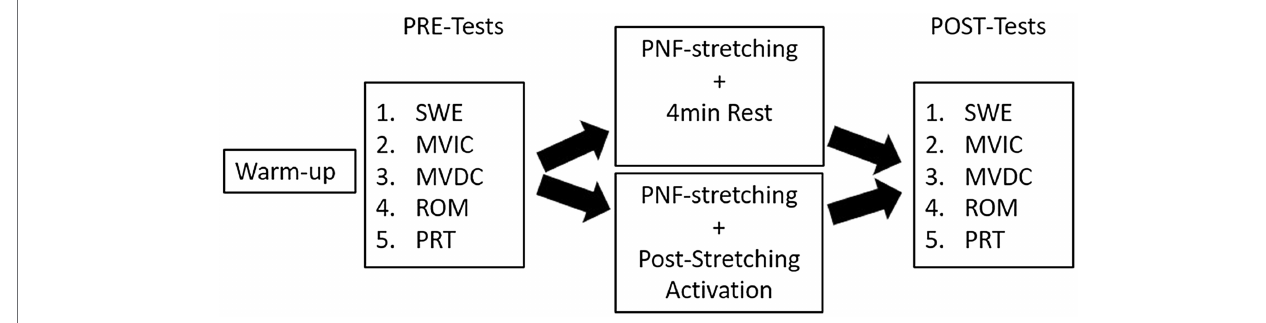
FIGURE 1 | Overview of the test procedure. SWE, shear wave elastography; MVIC, maximum voluntary isometric contraction; MVDC, maximum voluntary dynamic contraction; ROM, range of motion; PRT, passive resistive torque; control condition = 4 min rest; and post-stretching activation (PSA) = 2 × (skipping with 40 ground contacts, 20 jumps with straight legs, and high knee running with 40 ground